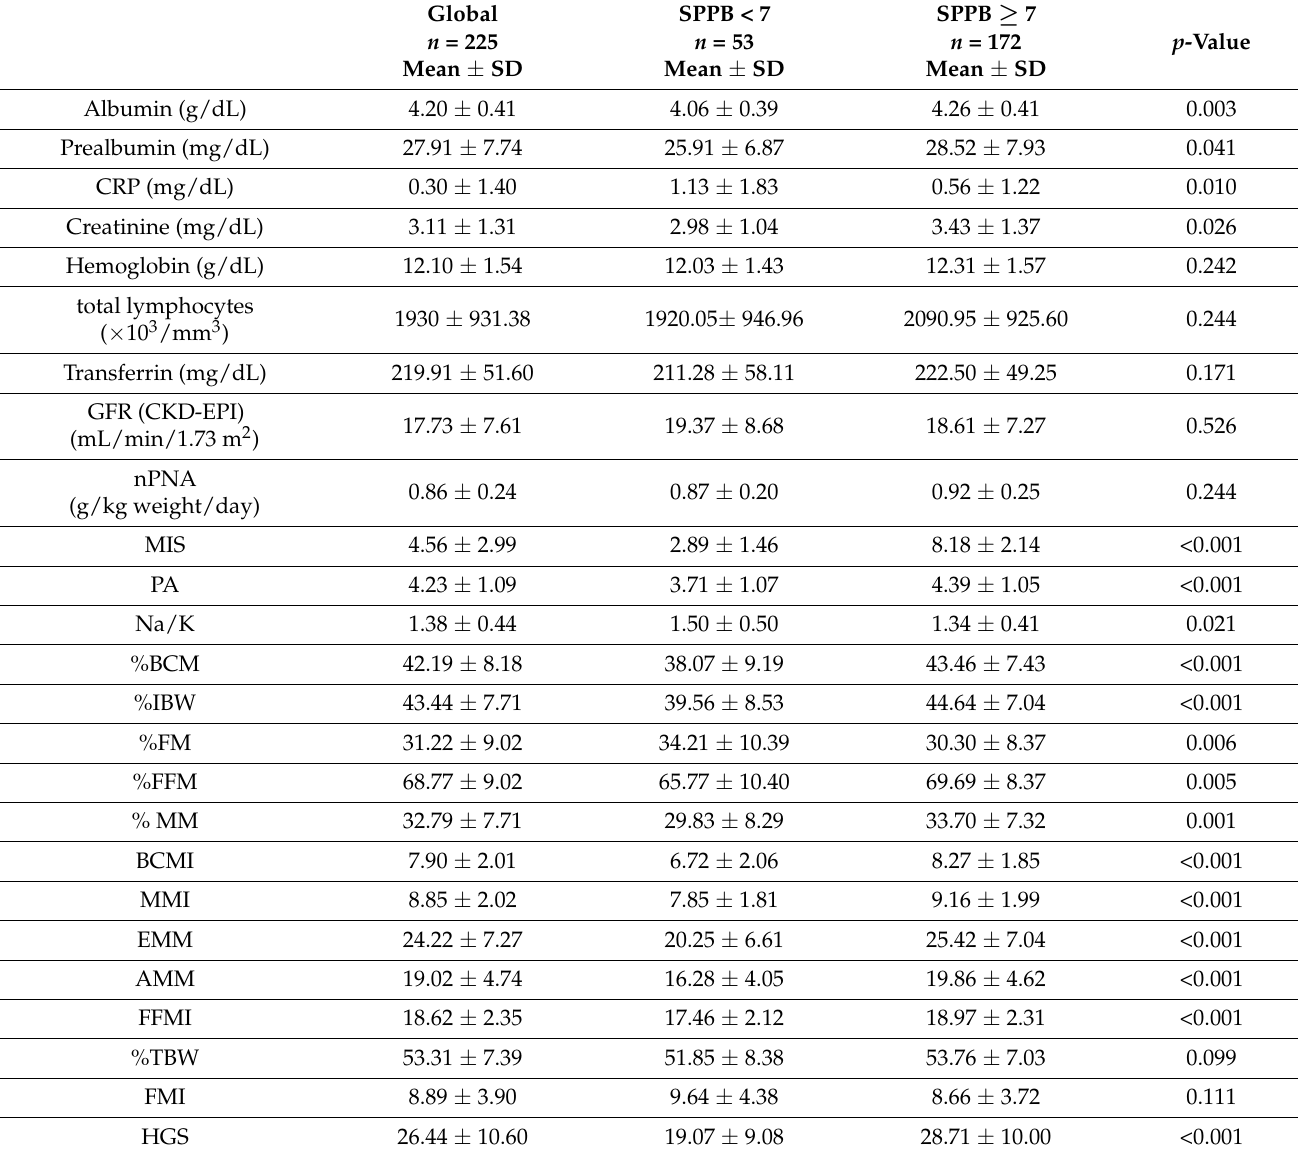
Table 4. Biochemical parameters according to SPPB cut-off